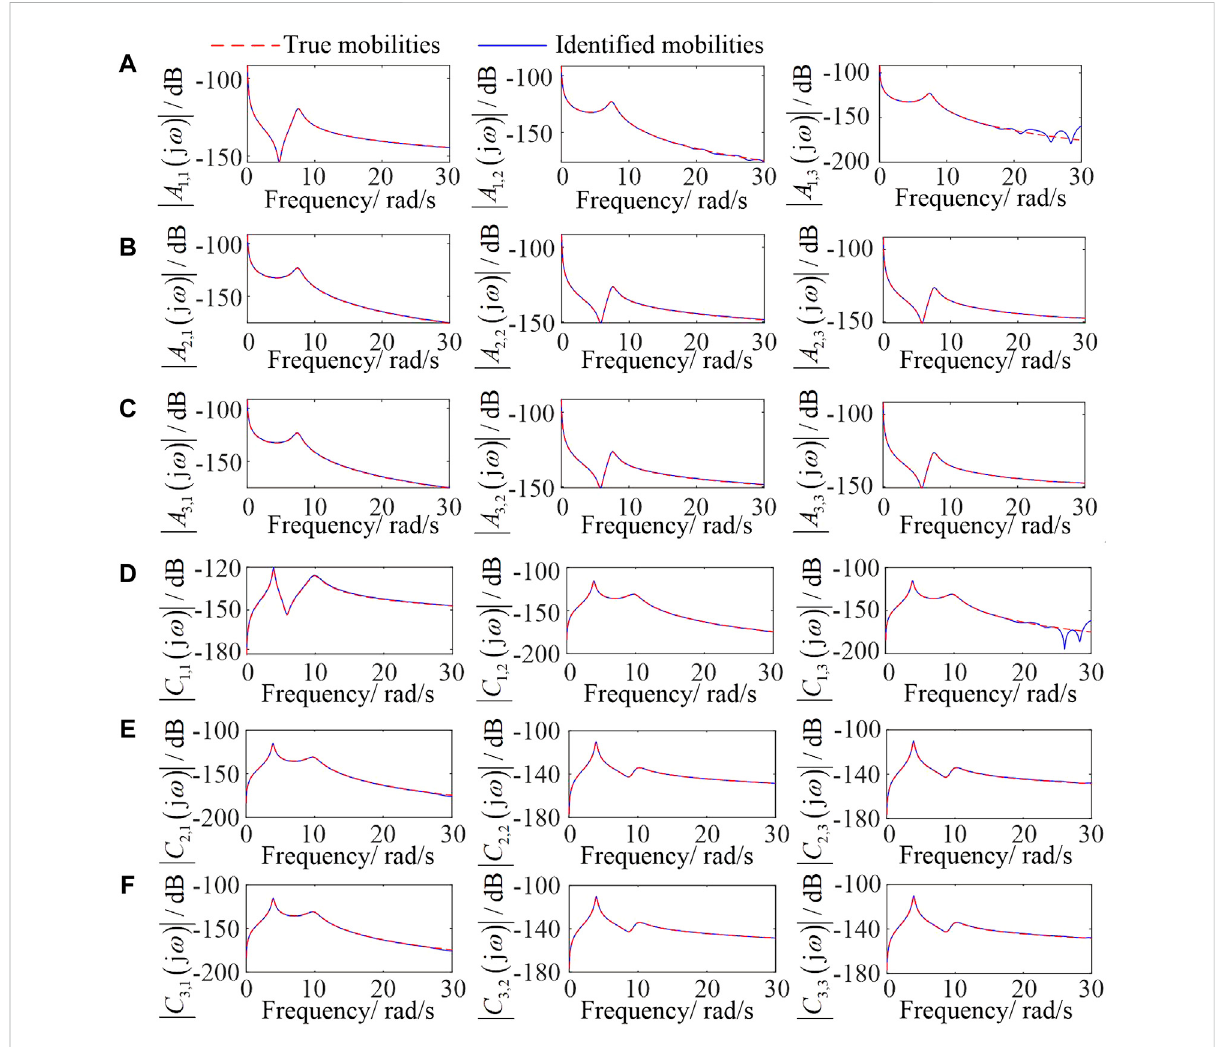
FIGURE 5 Mobilities of the 4-DoF building system. (A-C): The mobilities of layer A, (D-F): The mobilities of layer B.